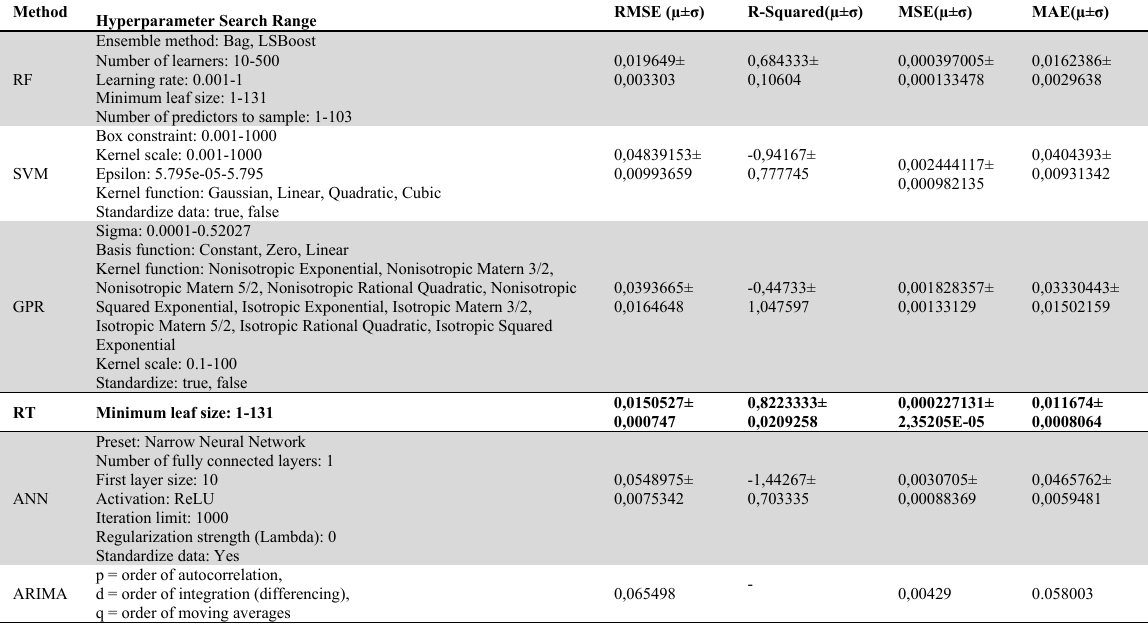
Model Evaluation of Different Methods on Test Data